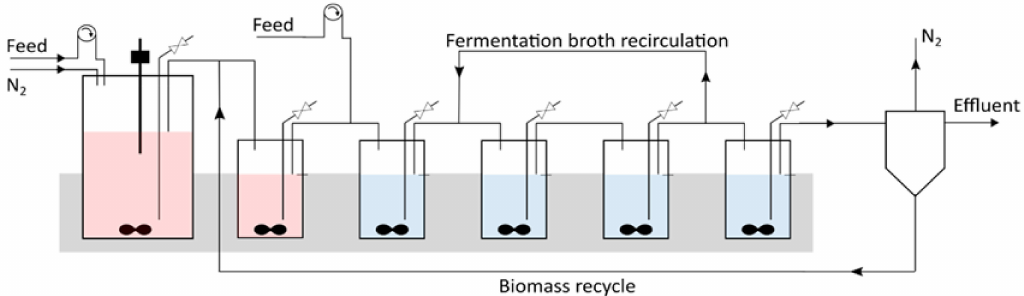
Figure 8. Possible modifications of the linear cascade of bioreactors to develop new fermentation strategies. The modifications in Figure 8 serve different purposes: